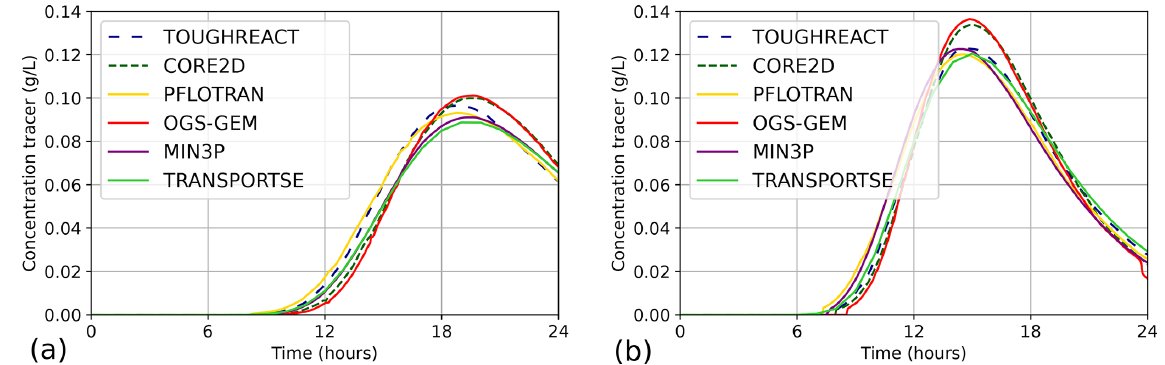
Figure 5. Concentration of tracer at (a) observation points c and (b) d at different times calculated by TRANSPORTSE-PHREEQC in comparison against the results documented by Poonoosamy et al. (2021).